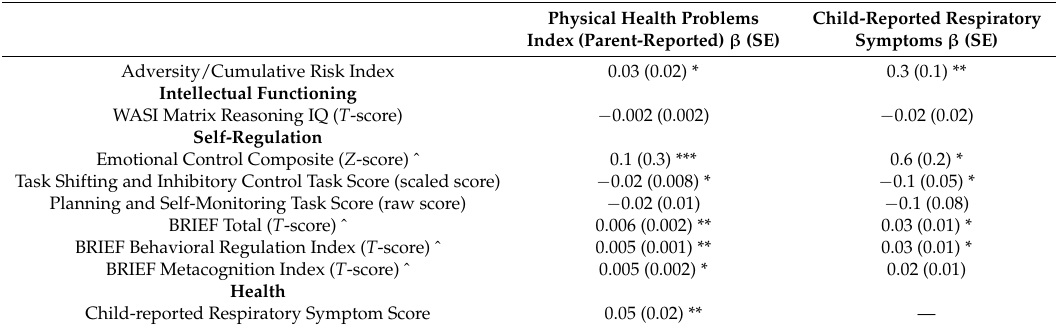
Table 3. Multivariable Linear Regression Analysis of Predictors of Child Physical